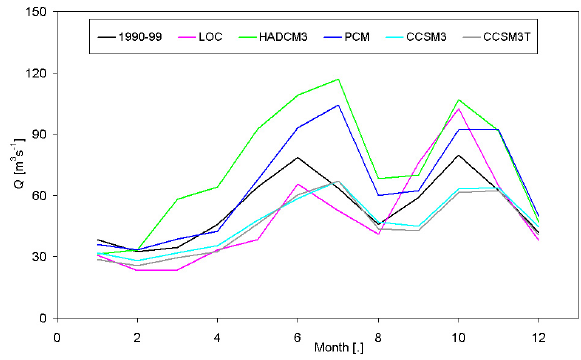
Fig. 9. Oglio at Sarnico. Scenario simulations, period 2045–2054. Average monthly discharges. CCSM3 and CCSM3 are plotted in different colors for readability.